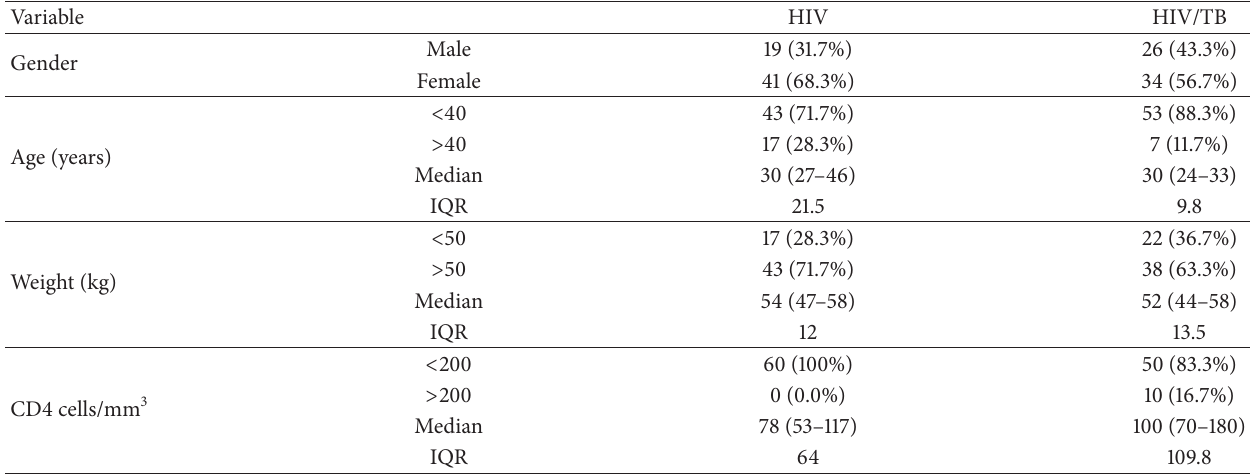
Table 1: Patients’ baseline